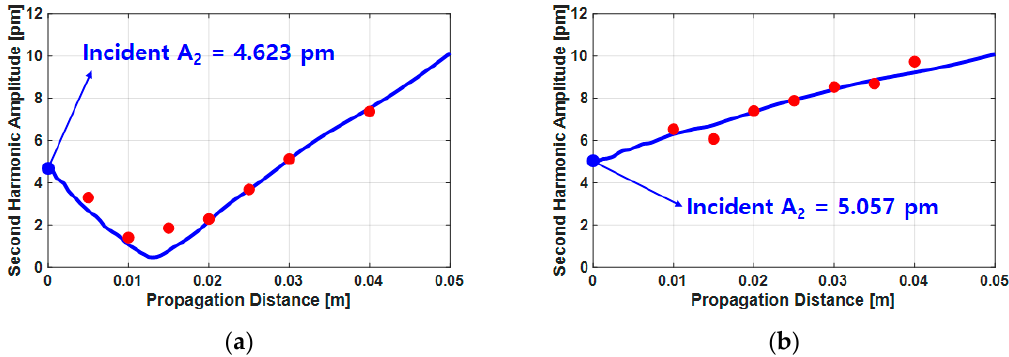
Figure 14. Results of the displacement amplitude of the second harmonic wave according to propagation distance in ( a ) fused silica and ( b ) Al6061-T6.